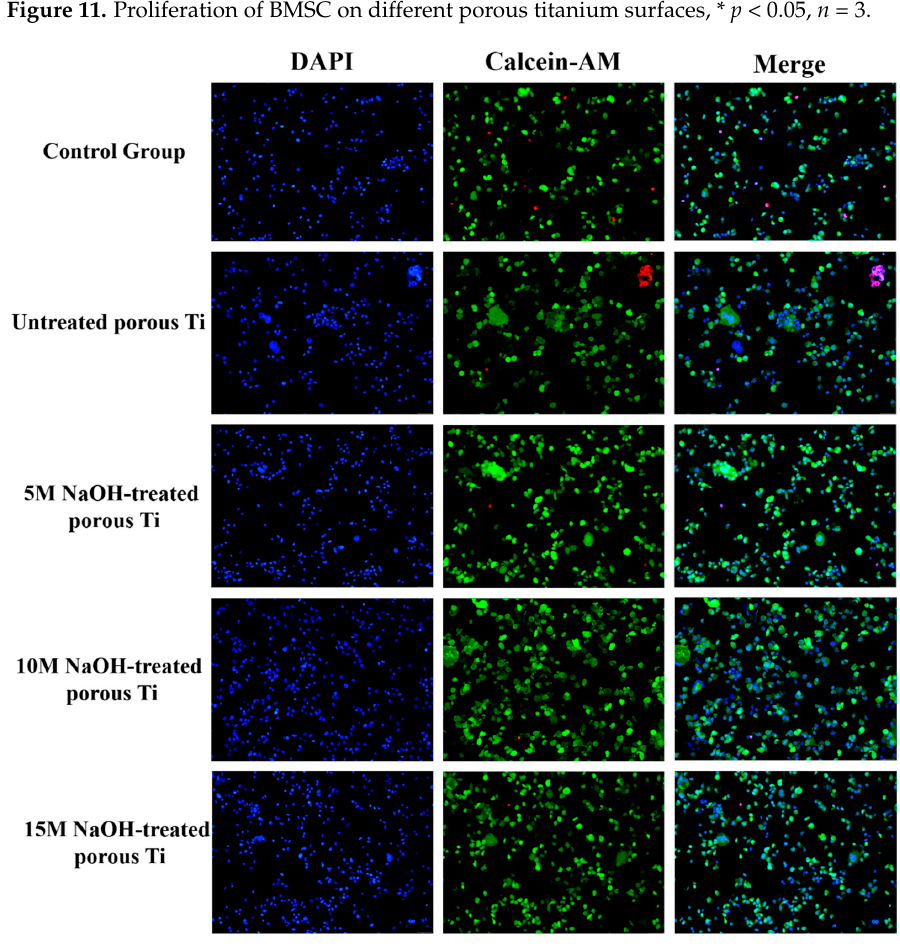
Figure 12. Live and dead cell staining of BMSC on different porous Ti surfaces. Blue stains are cell nuclei, green cells are live cells, and red cells are dead.